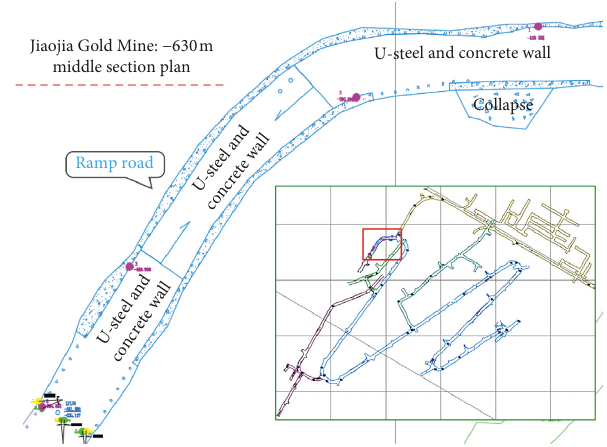
Figure 20: Jiaojia Gold Mine: 630m midsection −